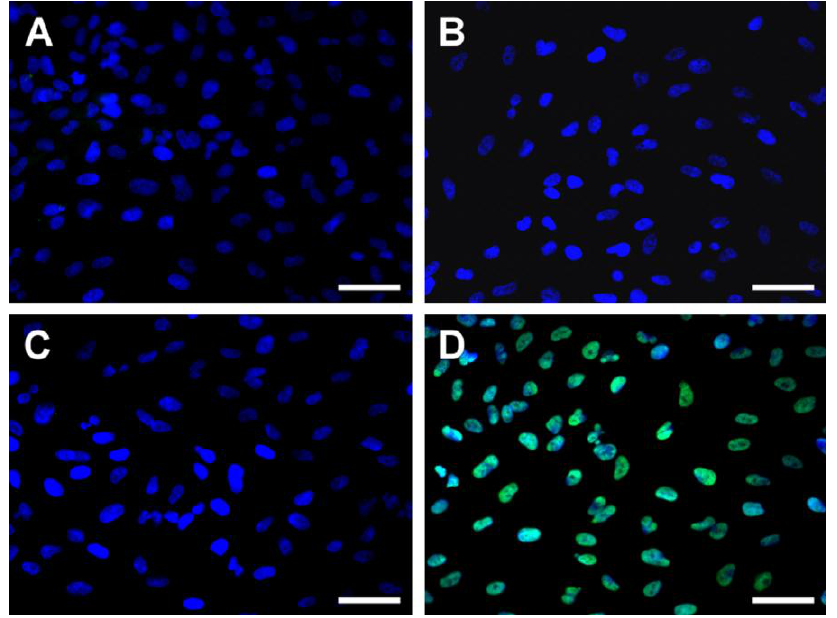
Figure 8. Apoptotic cells labeled with TUNEL assay in the ARPE-19 cultures. Fluorescence micrographs of control cells (without materials) ( A ), and cells after exposure to 5 mg of different types of chitosan membranes ( B ) Chi, ( C ) GP-chi, and ( D ) GTA-chi for 24 h at 37 °C. Blue fluorescence is DAPI nuclei staining. Green fluorescence is TUNEL-positive nuclei staining. Scale bars indicate 30 μm.